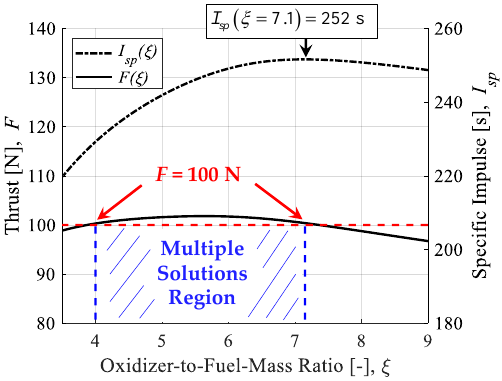
Figure 2. Example of multiple ξ solutions in the Nozzle Throat Reconstruction Technique (NTRT). 210